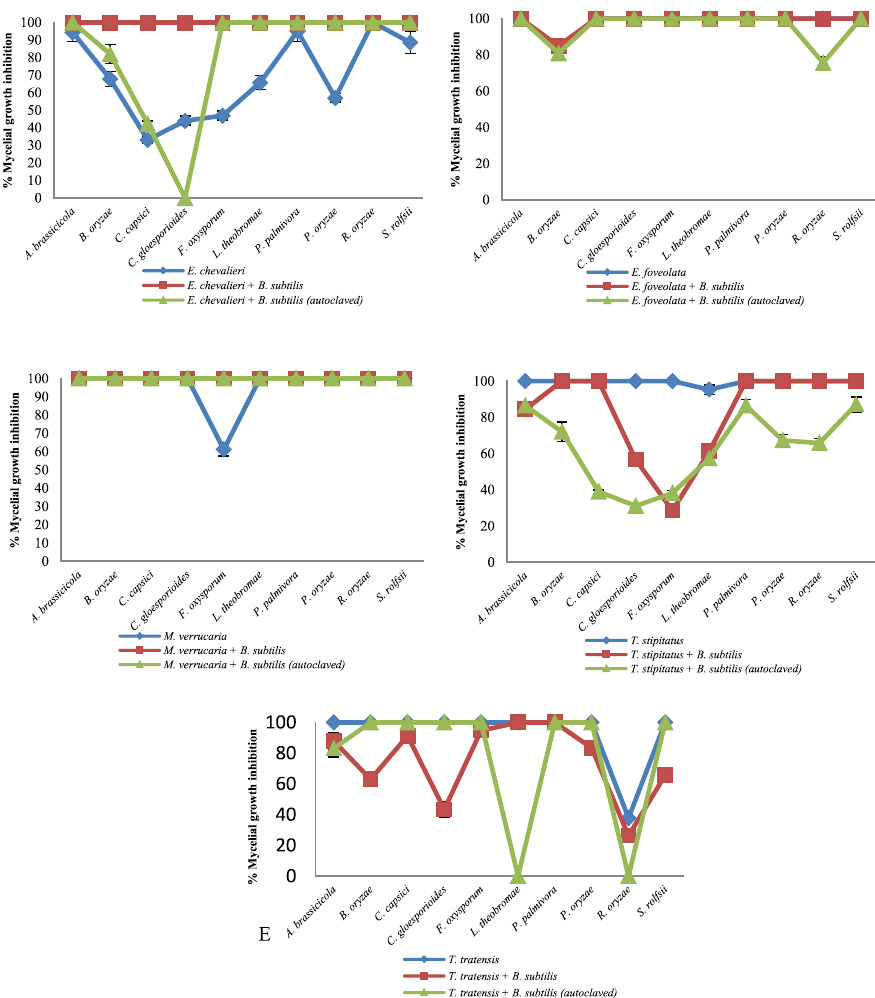
Fig. 1 Inhibitory effect of crude extracts obtained from marine-derived fungi and co-culturing with B. subtilis against plant pathogenic fungi at 10 g L -1